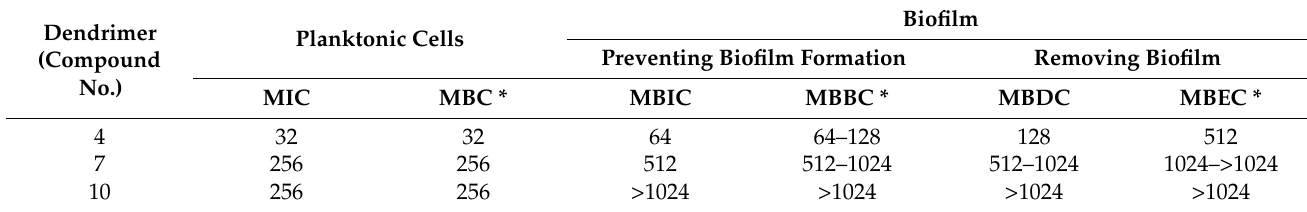
Table 1. Antibacterial activity of cationic CBS dendrimer ( 4 ) and with pegylated cationic CBS dendrimer PEG-800 ( 7 ) or PEG-2000 ( 10 ) against P. aeruginosa planktonic cells and biofilm. Data are given in mg/L.